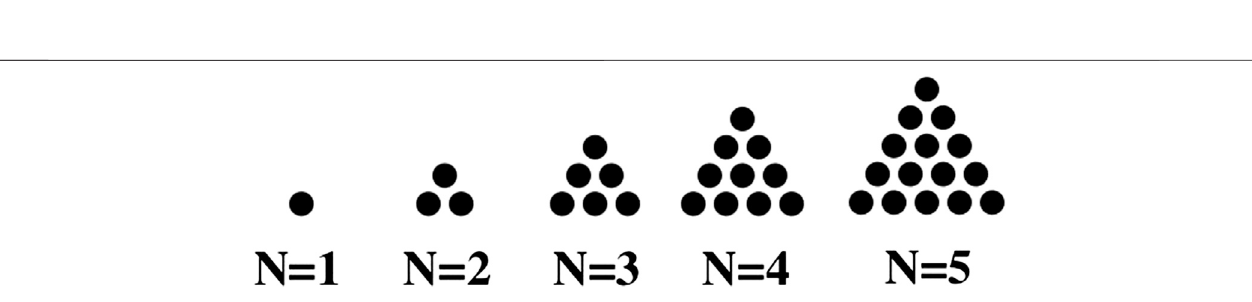
FIGURE 4 | The fi rst fi ve triangular numbers. They are represented by the number of solid dots within each triangle.